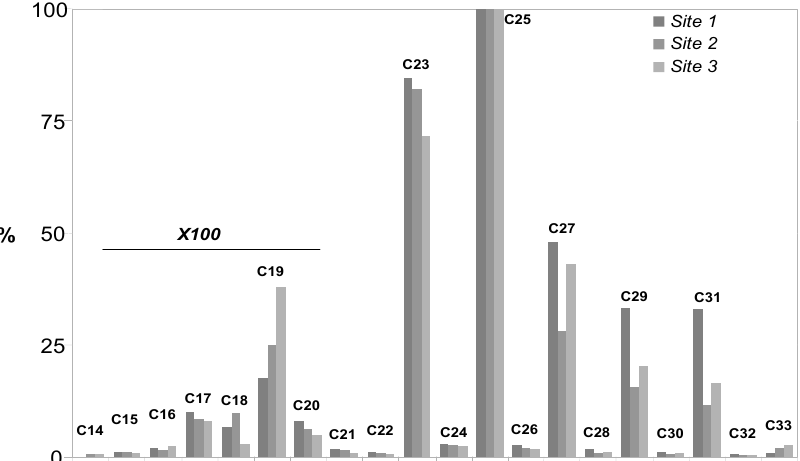
Figure 2. Comparative n-hydrocarbon distributions (percent contribution vs. carbon number) for individual homologs in the monitoring honeybee samples (data normalized to the nC25). × 100 = values multiplied by 100.